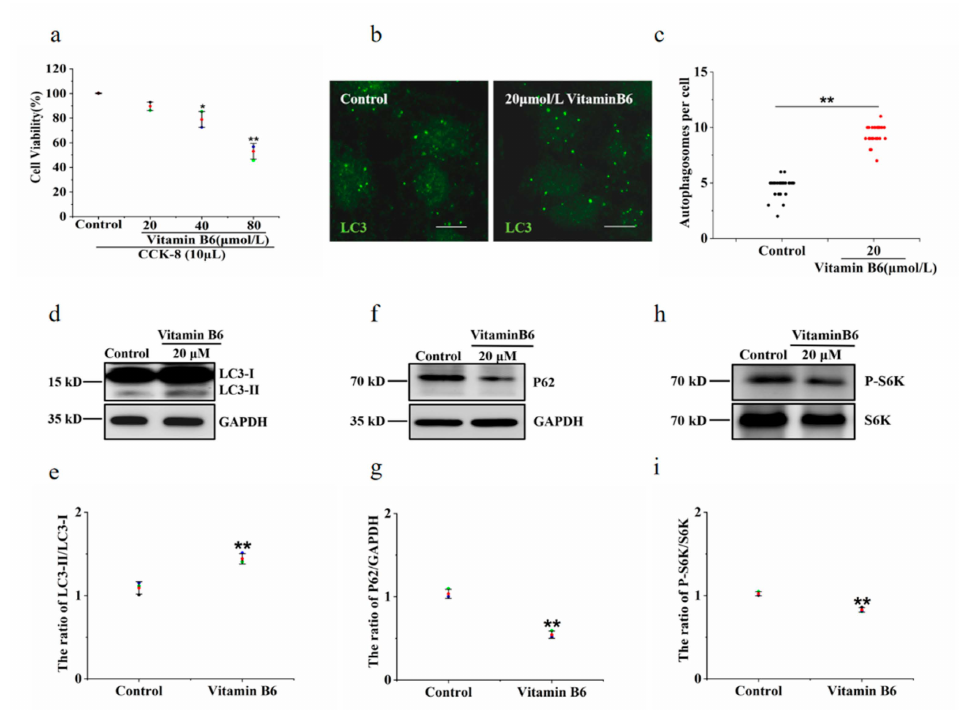
Figure 3. Vitamin B6 induced autophagy in RIN-m5F cells. ( a ) Cells were treated with the indi- cated concentration of vitamin B6, and cytotoxicity was assayed using a CCK-8 kit. Error bars, s.d. ** p < 0.01, * p < 0.05 indicates significant differences compared with the control group by one-way ANOVA. ( b ) RIN-m5F cells were treated with 20 µ M vitamin B6 for 24 h and stained with